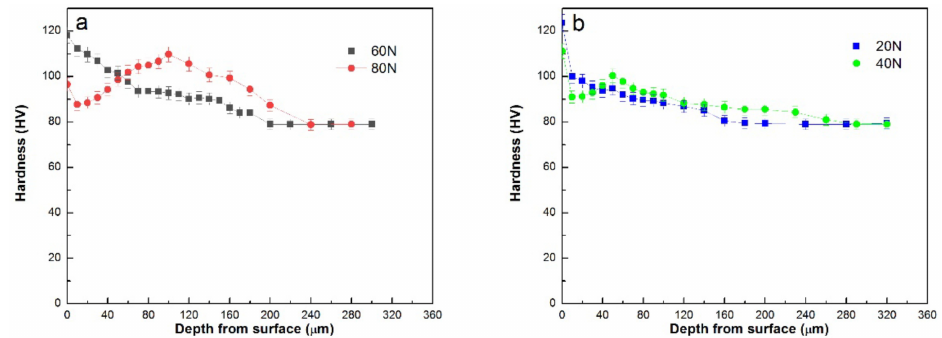
Figure 7. Microhardness versus depth from surface at 100 ◦ C ( a ) and 200 ◦ C ( b